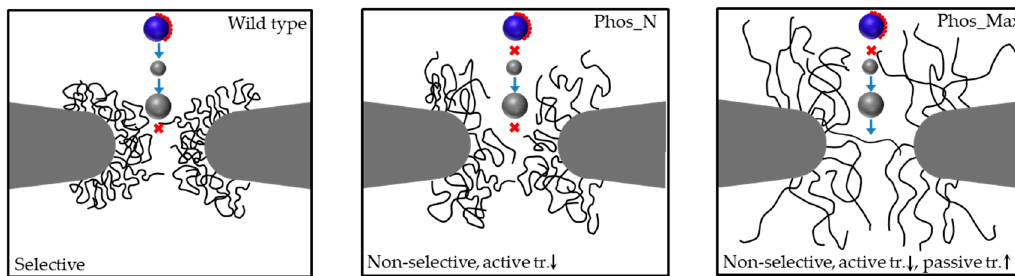
Figure 8. Summary of simulation results on wildtype and phosphorylated yeast NPCs, showing active transport of Kap95 (blue sphere with red dots representing the hydrophobic binding sites) and passive transport of inert particles (grey spheres of diameter 4 nm and 8.5 nm). The FG-Nups are represented by black filaments. The blue arrows indicate observed transport and the red crosses indicate prohibited transport within the 2 µ s simulation